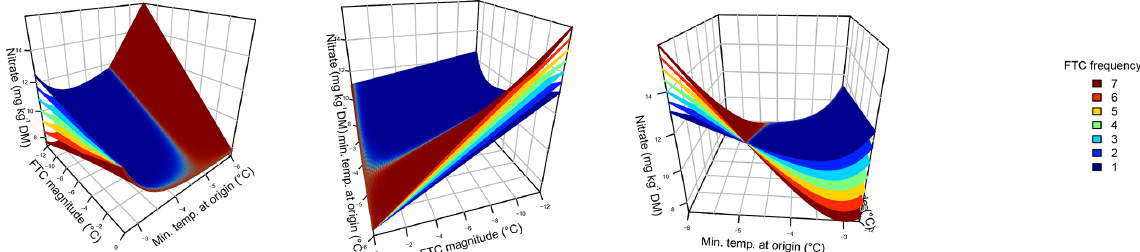
Figure 1. Nitrate concentrations were best explained by the threefold interactive effects of winter climatic origin (expressed as long-term mean minimum winter temperature at the origin), FTC magnitude (expressed as the minimum temperature experienced during the FTC manipulation and displayed for freezing temperatures), and FTC frequency during the FTC manipulation. FTC: freeze–thaw cycle. The four-dimensional representation is displayed from three different angles (see Supplement B for an animated version) and is based on the best model fit in the hierarchical regression analysis (model 15 in Table 3 with coefficients a 1 = 7 . 70092; a 2 = − 22 . 57795; a 3 = 1 . 52874;